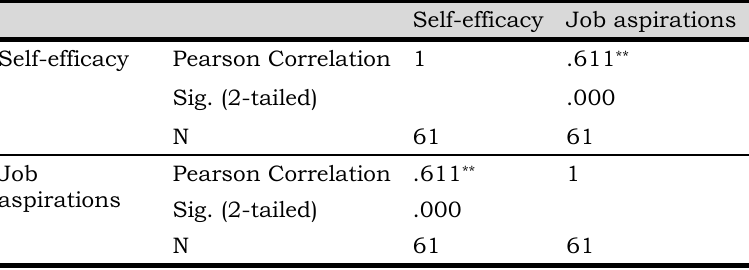
Table 5. Correlation between Self-efficacy and career